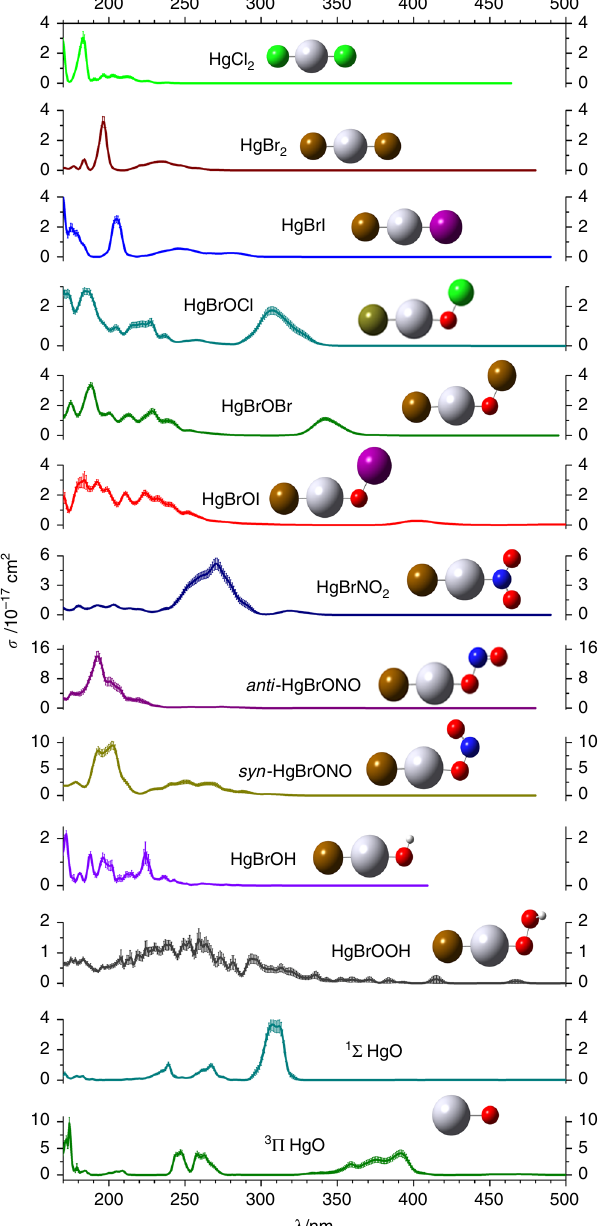
Fig. 2 Ball-and-stick representation and computed UV-VIS absorption spectra and cross sections ( σ , cm 2 ) of the Hg(II) compounds studied in the present work. The light-coloured areas correspond to the uncertainty of the cross section due to the statistical sampling. Note the different range of σ values for some of the spectra. Also note that only wavelengths >290 nm are relevant for ambient tropospheric conditions